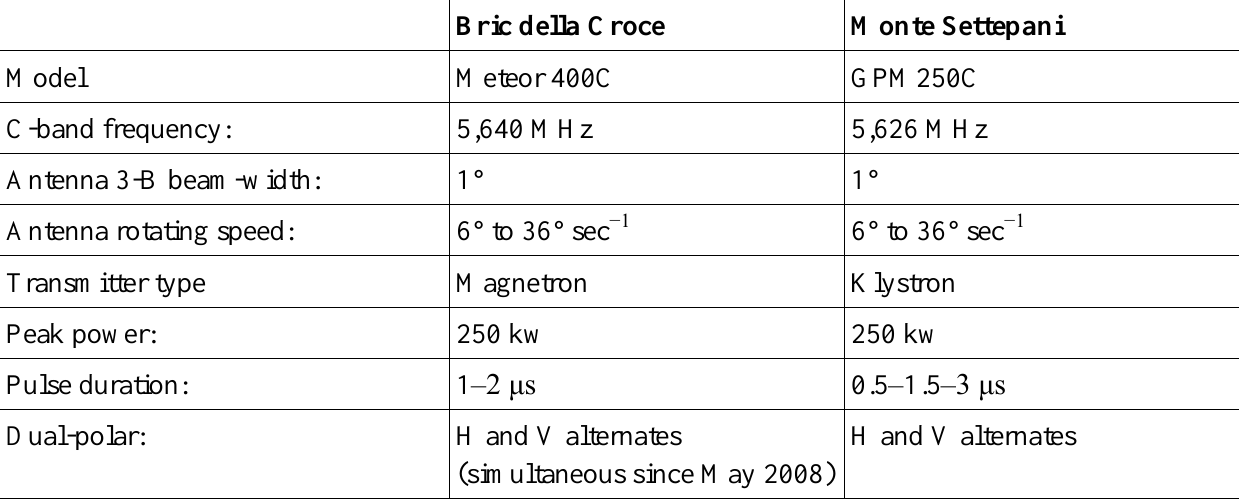
Table 1. Main Arpa Piemonte radar